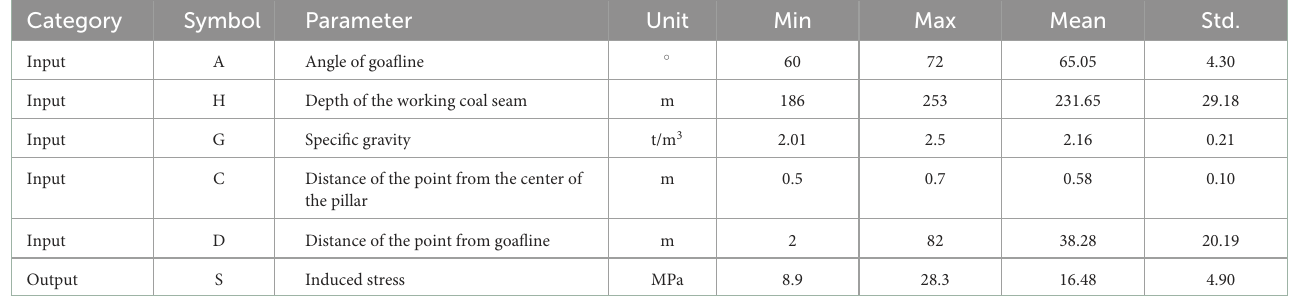
TABLE 1 Descriptive statistics for input and output